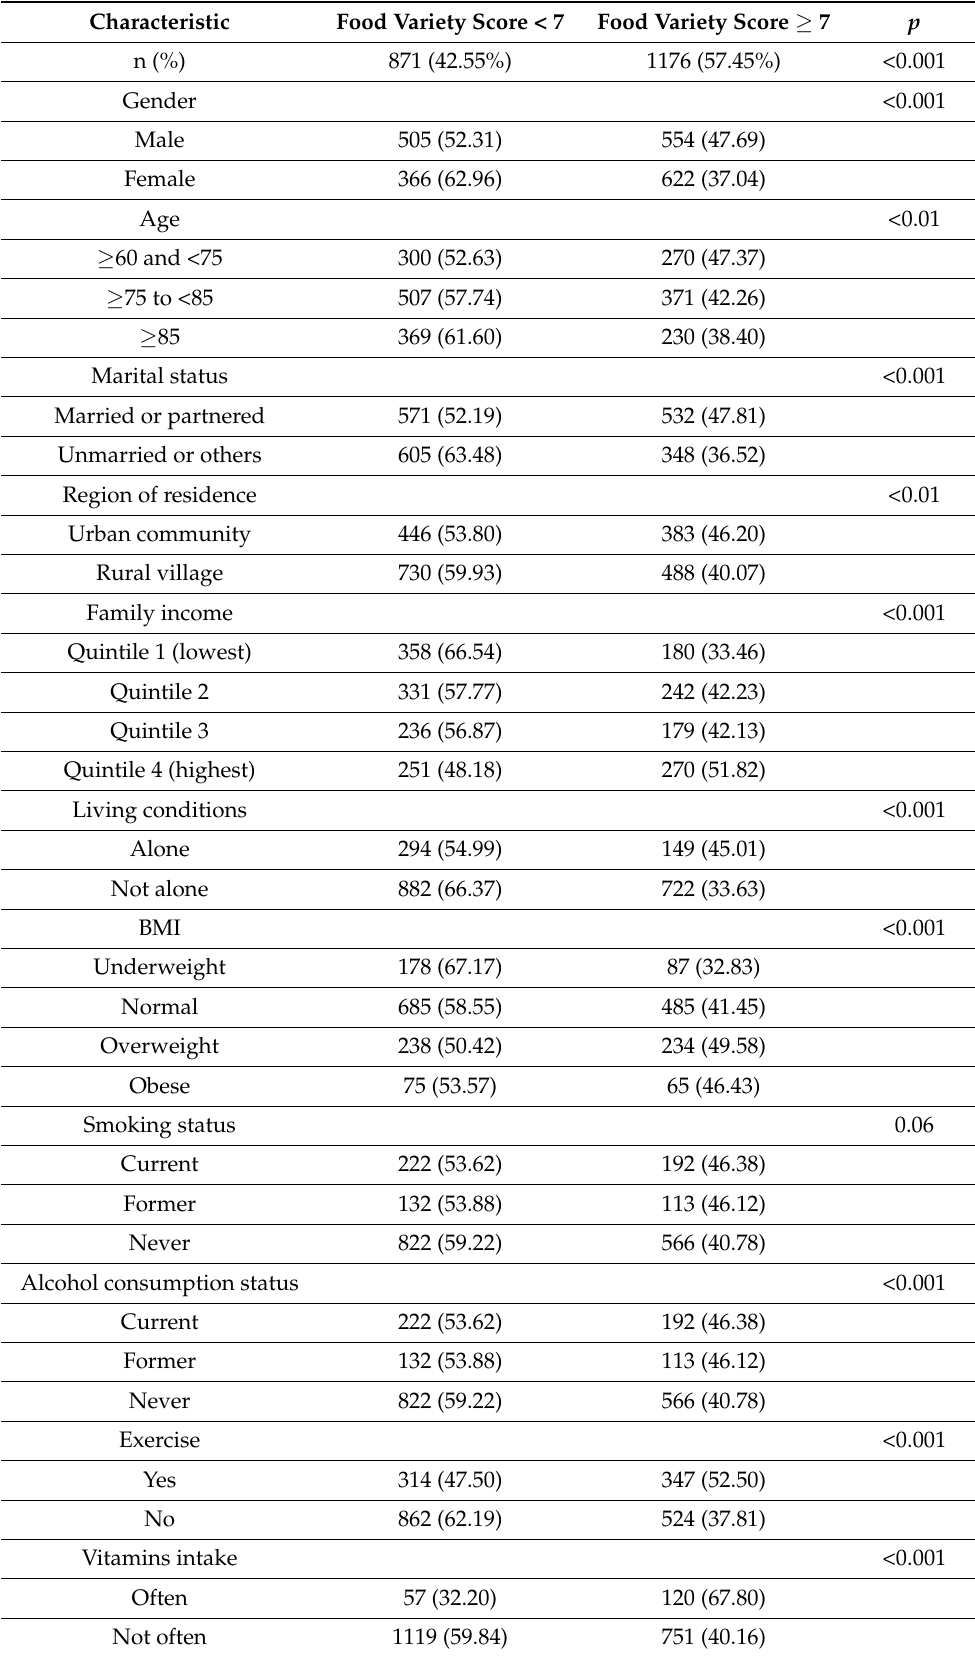
Table 1. Baseline characteristics of Chinese older adults by the food variety